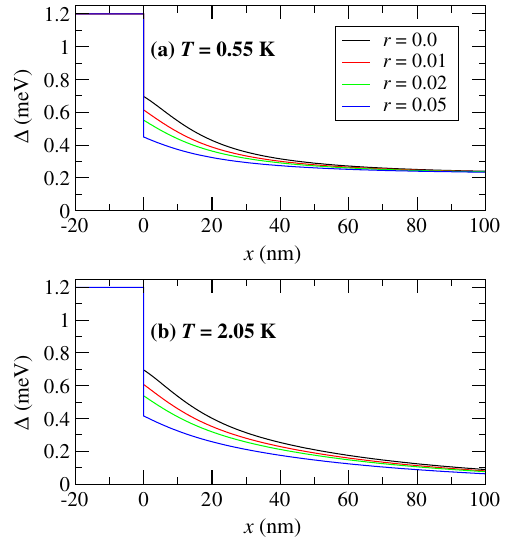
FIG. 11. Self-consistent order parameter as a function of the position for different values of r and for temperatures (a) T ¼ 0 . 55 K and (b) T ¼ 2 . 05 K. These profiles correspond to the cases shown in Figs. 9 and 10.